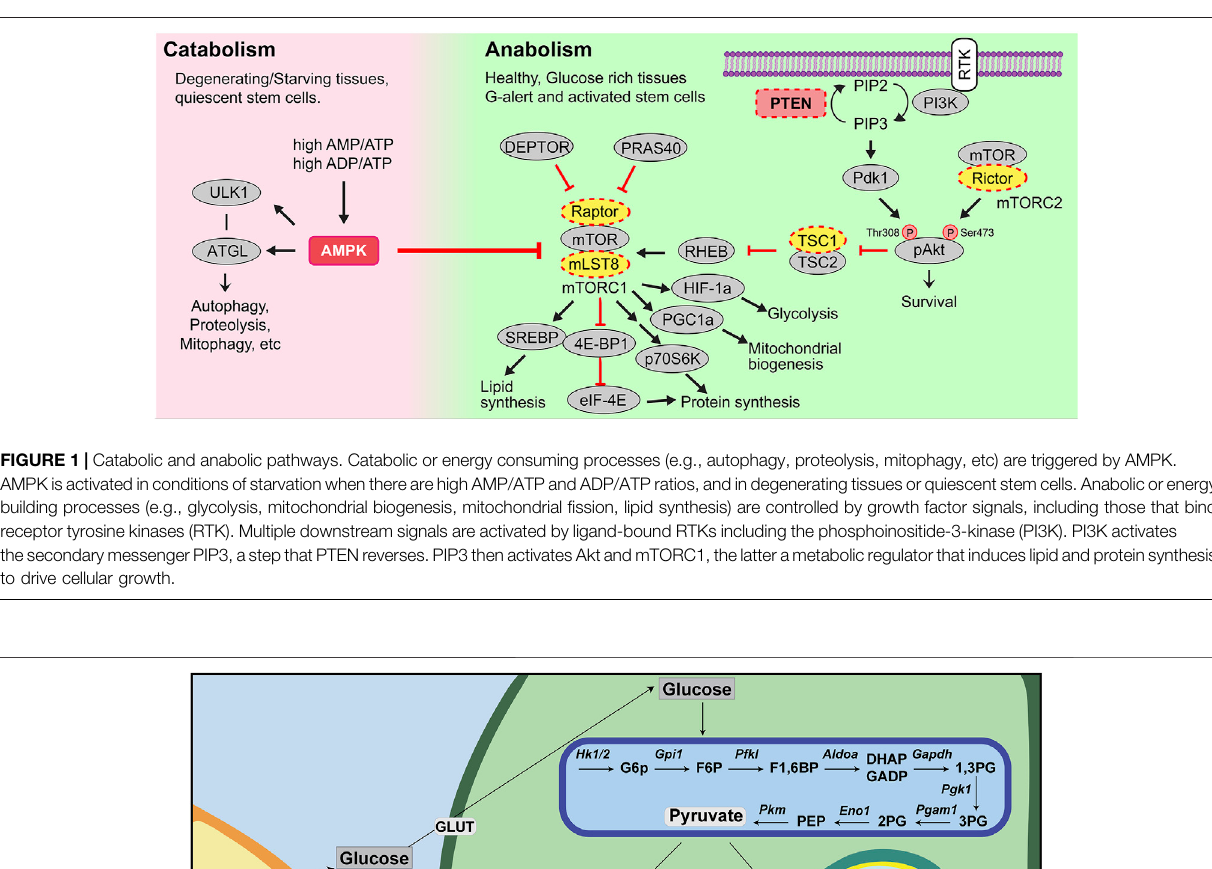
Frontiers in Cell and Developmental Biology |